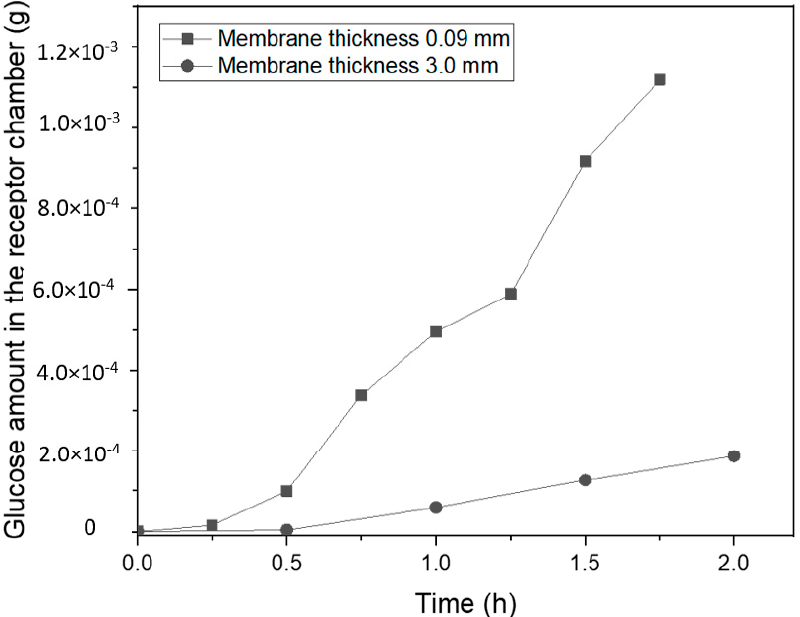
Figure 3. Comparison of the e ff ect of the BNC membrane thickness on glucose permeation, as measured by the amount of glucose di ff used through the BNC membrane over